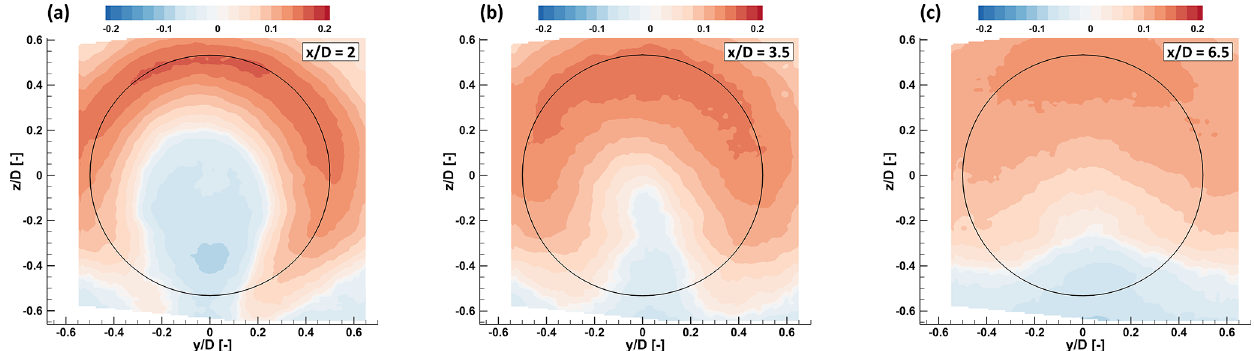
Figure 17. Added turbulence intensity I add for UTD-HT inflow at several downstream distances. The black circle denotes the rotor circum- ference.